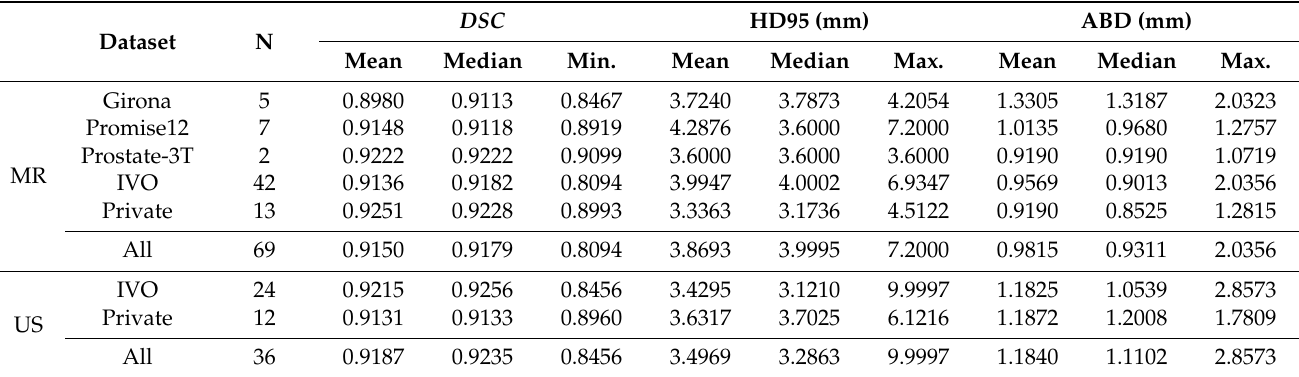
Table 2. Quantitative results for all datasets and models.